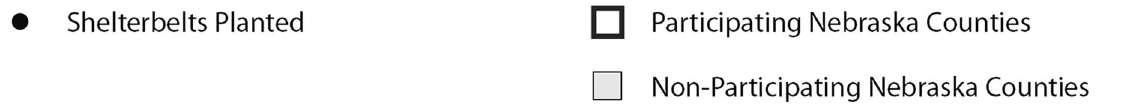
Fig. 7 Nebraska Historical Inventory: Prairie State Forestry Project (1935 – 1942). Map illustrating every shelterbelt planted across the state of Nebraska during the eight-year project (Source: the authors)